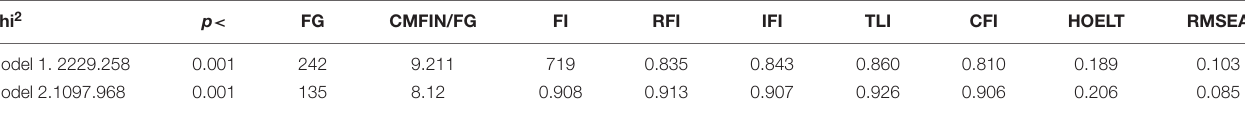
TABLE 5 | Standardized direct effects (default